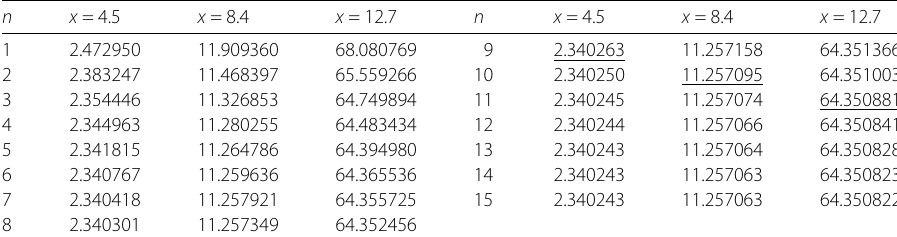
Table 1 Some numerical results for calculation of Γ q ( x ) with constant q = 1 n = 1,2, ... ,15 of Algorithm 2